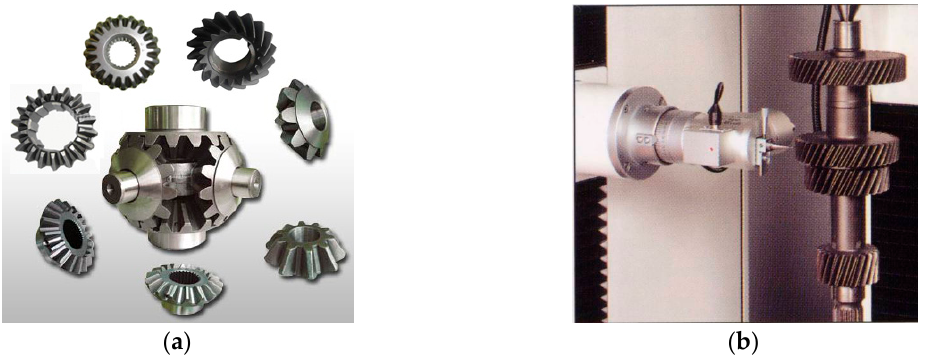
Figure 1. ( a ) Samples of bevel gear; ( b ) Gear measuring instrument of Osaka Seimitsu Precision Machinery Corporation.